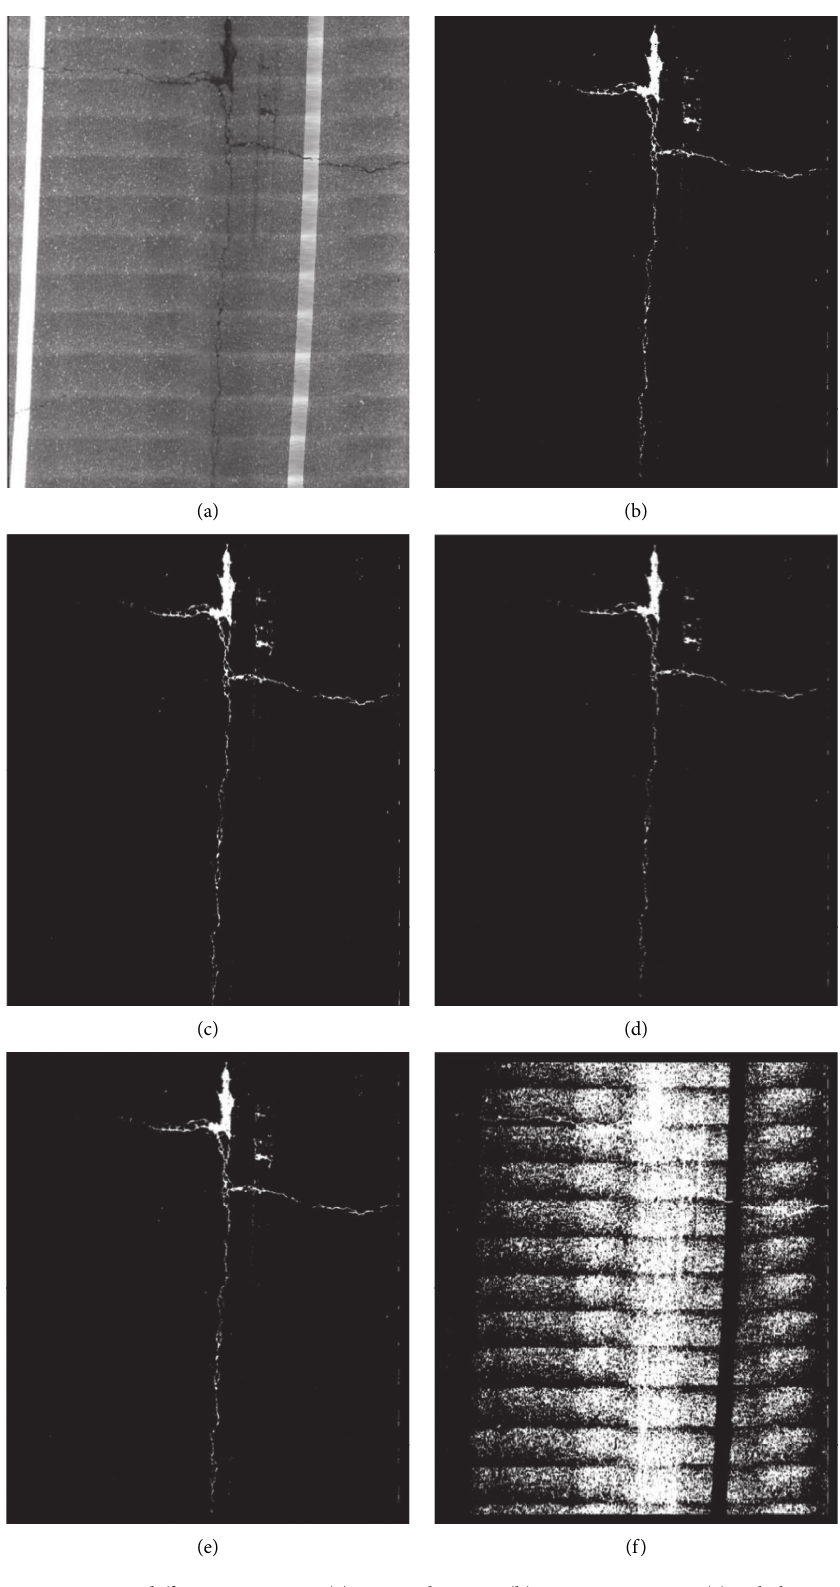
Figure 6: Image segmentation using different operators. (a) Original image. (b) Prewitt operator. (c) Sobel operator. (d) LoG operator. (e) Canny operator. (f) Segmentation without